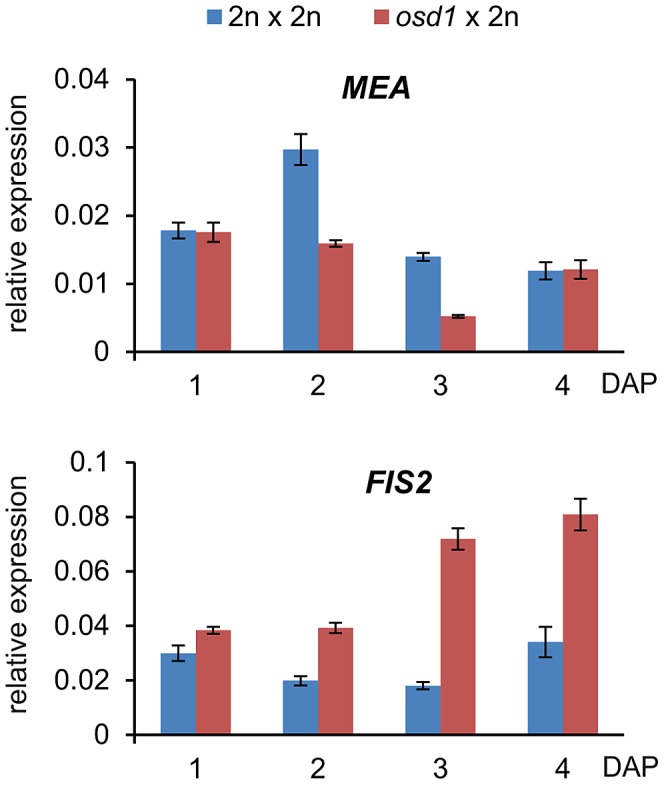
Expression Level of FIS2 but Not of MEA Is Increased in osd1×2n Crosses.Quantitative RT-PCR analysis of MEA and FIS2 expression in seeds derived from osd1×2n crosses at 1–4 days after pollination (DAP). Error bars indicate s.e.m.